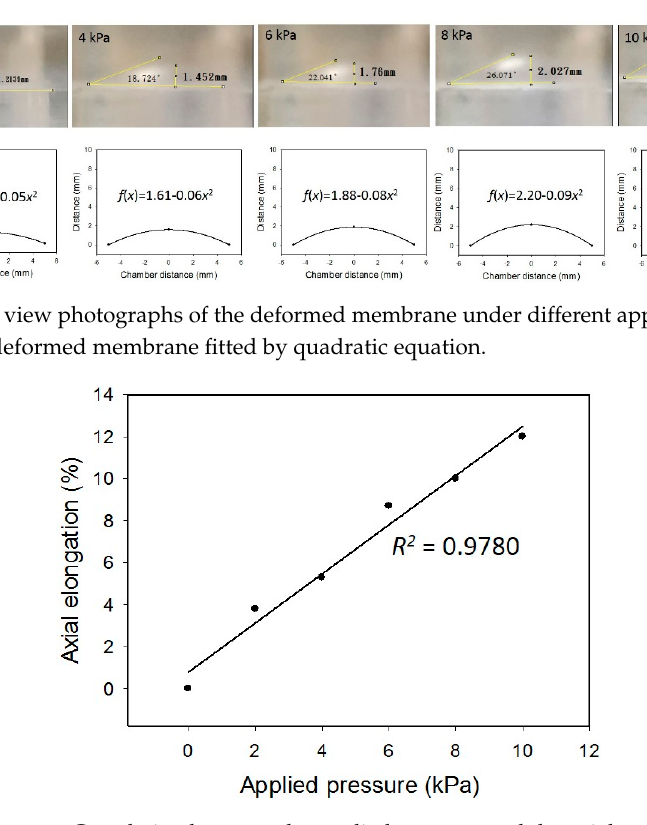
Figure 5. Correlation between the applied pressure and the axial strain.